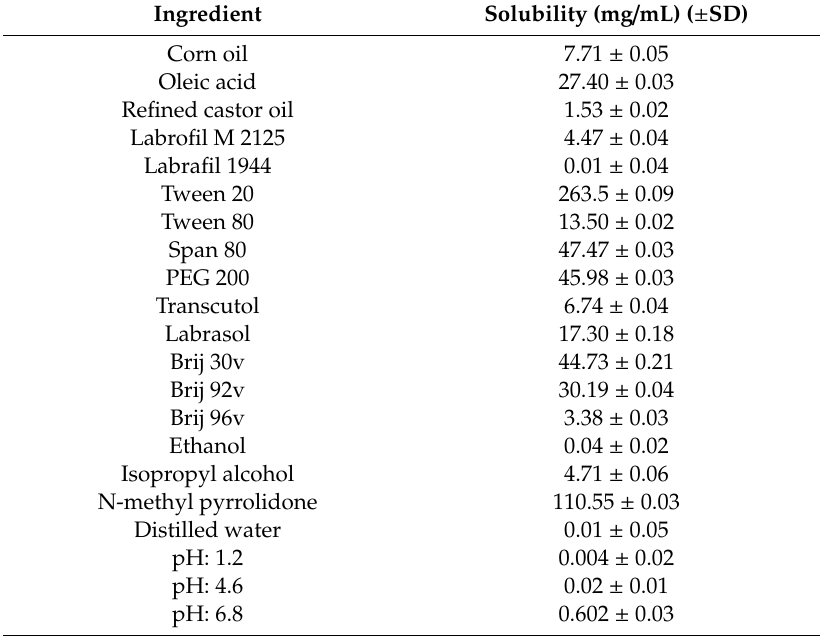
Table 1. Solubility (mean ± SD) of AtrCa in various SEDDS oils, surfactants, and cosurfactants.